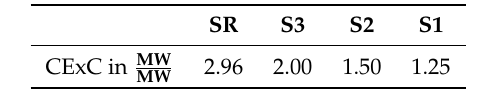
Table 8. Electricity CExC-factor for the sensitivity analysis.